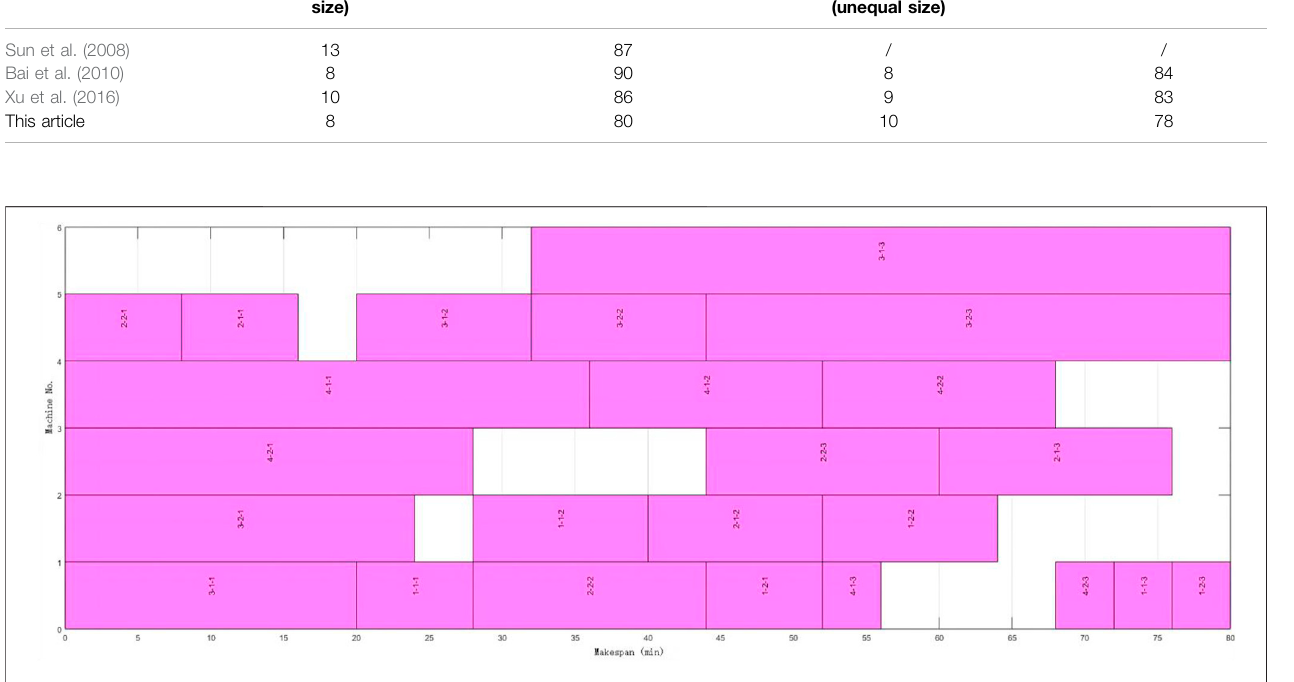
FIGURE 8 | 4 × 6 Gantt chart of equal-size batch splitting and